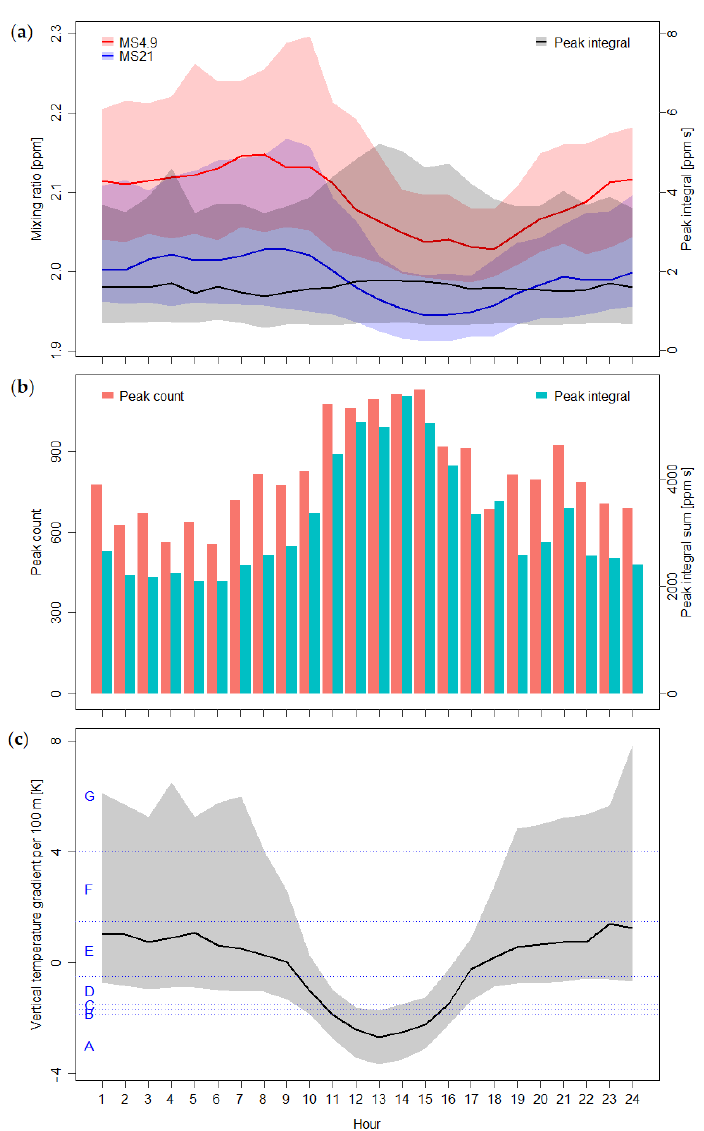
Figure 2. ( a ) Diurnal cycle of background mixing ratios at MS21 (B MS21 ) and MS4.9 (B MS4.9 ), and peak integral at MS4.9; lines represent median; shadows represent range between 25% quantile and 75% quantile; ( b ) Diurnal cycle of peak count and peak integral sum at MS4.9; ( c ) Diurnal cycle of the vertical temperature gradient; lines represent median, shadows represent range between 25% quantile and 75% quantile; blue: classification after Pasquill [38].